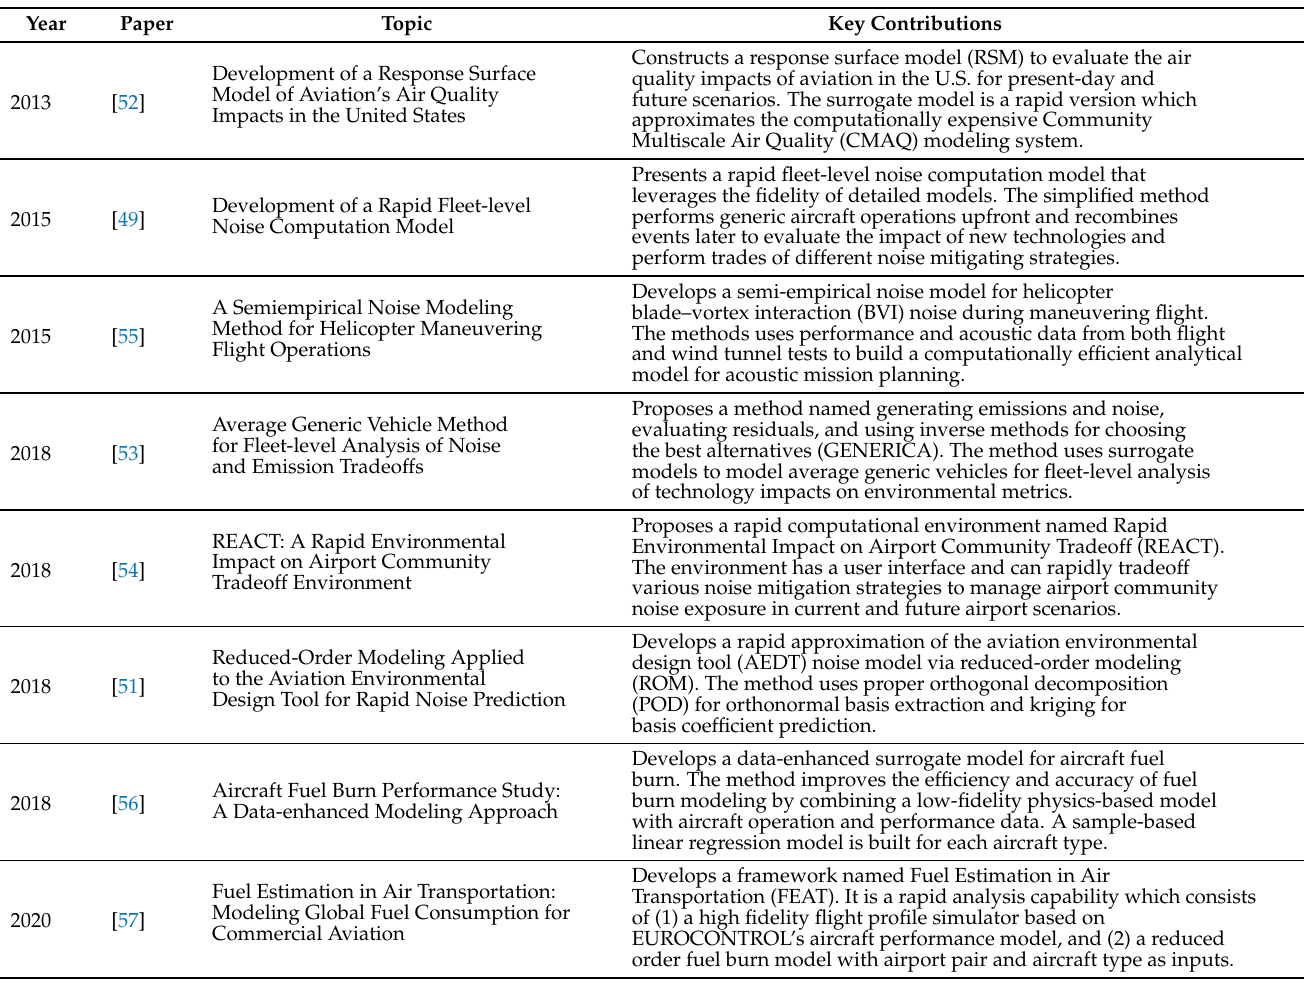
Table 3. Summary of representative papers in efficient